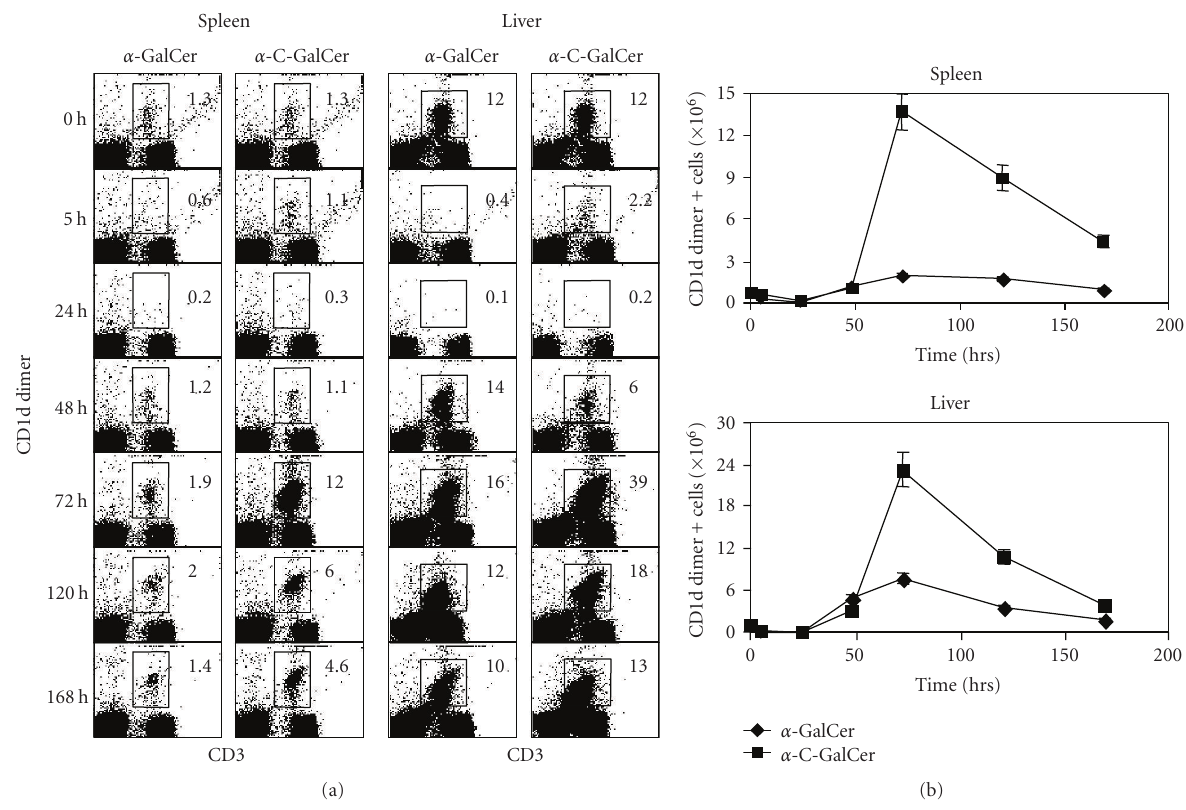
Figure 5: α -C-GalCer induces a slower and shorter in vivo downregulation of V α 14i TCRs and a greater in vivo proliferation of V α 14i NKT cells compared to α -GalCer. (a) Groups of 2WT C57BL/6 mice were injected i.p. with 1 μ g of α -GalCer or α -C-GalCer, and 0, 5, 24, 48, 72, 120, and 168 hours later splenocytes and liver lymphocytes were isolated and stained with α -GalCer-loaded mouse CD1d-IgG 1 dimers to assess the level of V α 14i NKT cells present. The numbers shown in the individual panels represent the percentage of V α 14i NKT cells present in the gated lymphocyte population. The data shown are representative of three independent experiments. (b) The average absolute numbers of V α 14i NKT cells in the spleens and livers of α -GalCer- and α -C-GalCer-treated mice at the various time points were calculated according to the following equation: (percentage of V α 14i NKT cells in the gated lymphocyte population) ∗ (percentage of total isolated cells represented by the gated lymphocyte population) ∗ (total number of isolated cells). The data shown are the average values calculated from three independent experiments + / −